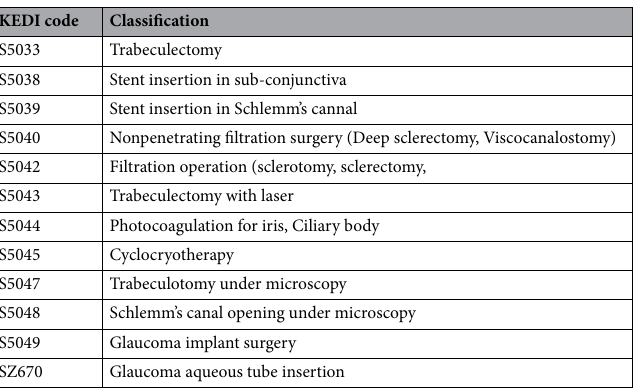
Table 6. Korean electronic data interchange codes for glaucoma surgery. KEDI Korean Standard Classification of